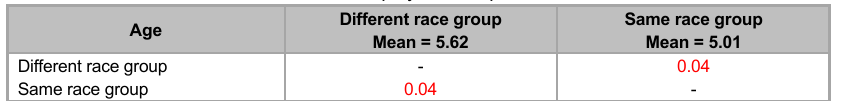
Post hoc test (Scheffe) with variable “same race/different race” and the Factor: “ratings based on equity” where p ≤ 0.05 Different race group Age Mean = 5.62 Different race group - Same race group 0.04